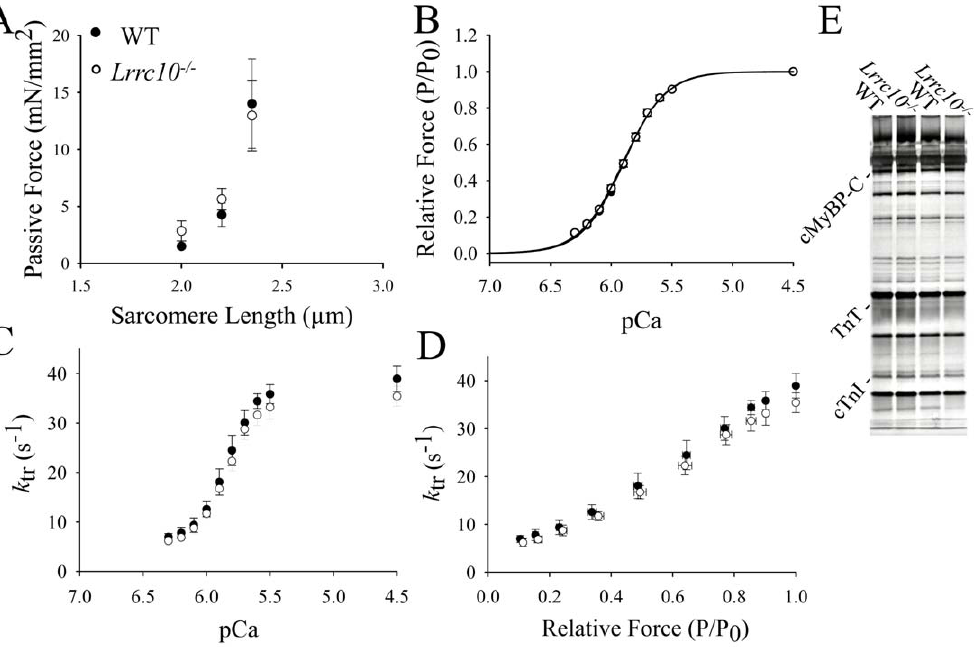
Figure 7. Contractility of skinned myocardium and myofibril protein composition are not altered in Lrrc10 2 / 2 mice. (A) SL-dependent increase in passive force is unaltered in Lrrc10 2 / 2 skinned trabeculae. The passive forces were measured in pCa 9.0 first at SL 2.00 m m then at 2.22 and finally at 2.35 m m in WT (n=4; closed circles) and Lrrc10 2 / 2 (n=4; open circles) skinned trabeculae. (B) Force-pCa relationships established at SL 2.20 m m yielded nearly identical sigmoidal plots in WT and Lrrc10 2 / 2 skinned trabeculae. (C–D) Deletion of Lrrc10 has no effect on the rate of force redevelopment. (C) k tr -pCa and (D) k tr -relative force relationships were established at SL 2.22 m m in skinned trabeculae. (E) Silver staining for myofibril protein composition in WT and Lrrc10 2 / 2 hearts.